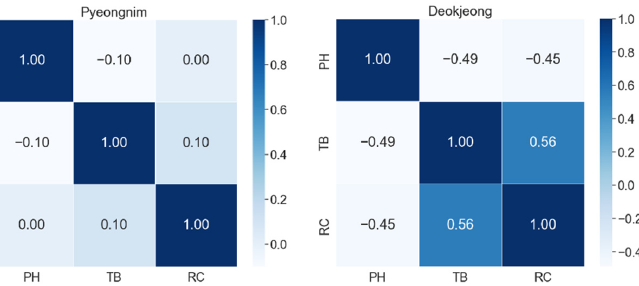
Figure 7. Spearman correlation coefficients for drinking water quality in the Seomjin River basin.